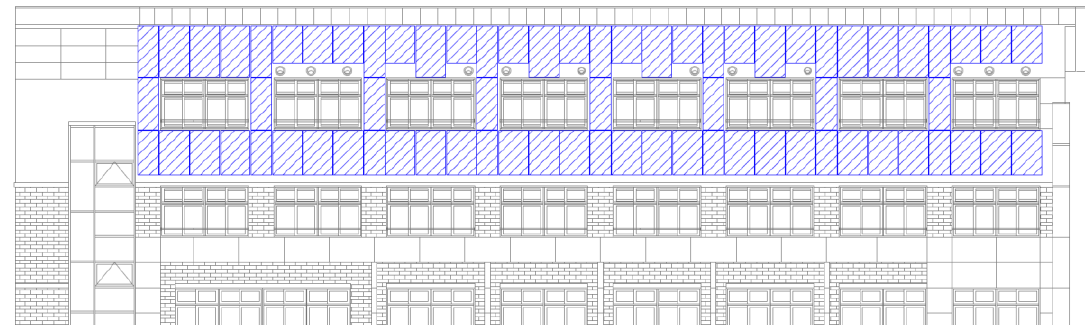
Figure 1. Air-type building integrated photovoltaic/thermal (BIPVT) collector on the demonstration building.